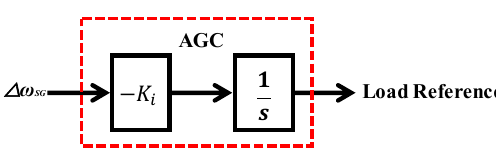
Figure 5. Automatic generation control (AGC).